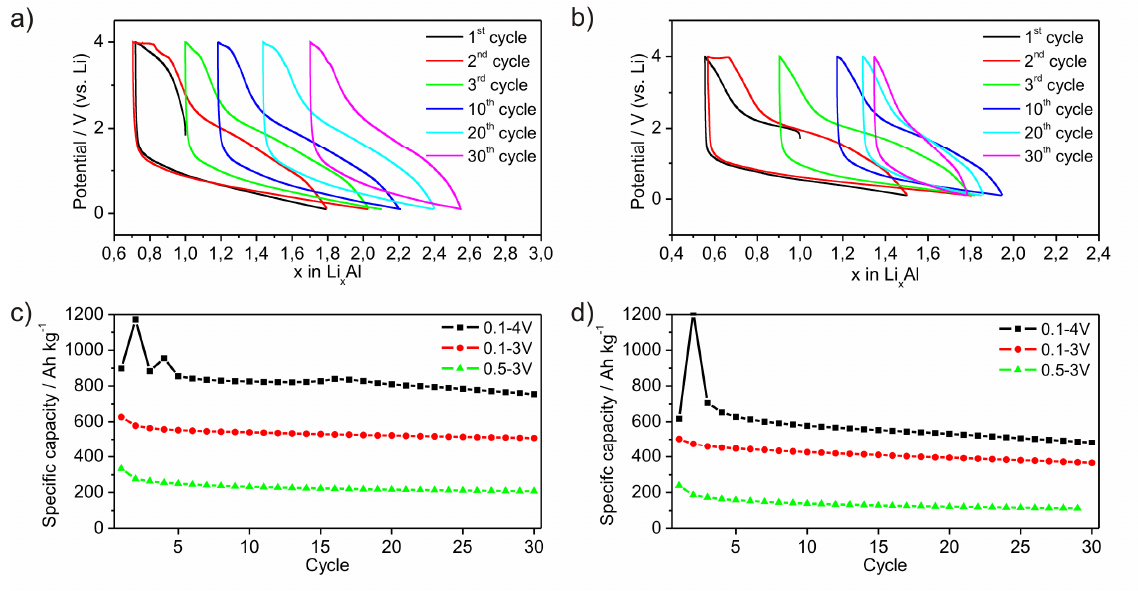
Figure 7. Lithiation process of ball milled amorphous Al P2 ( b ) versus potential. Development of specific capacities in dependency of different potential ranges for P1 ( c ) and P2 ( d ).